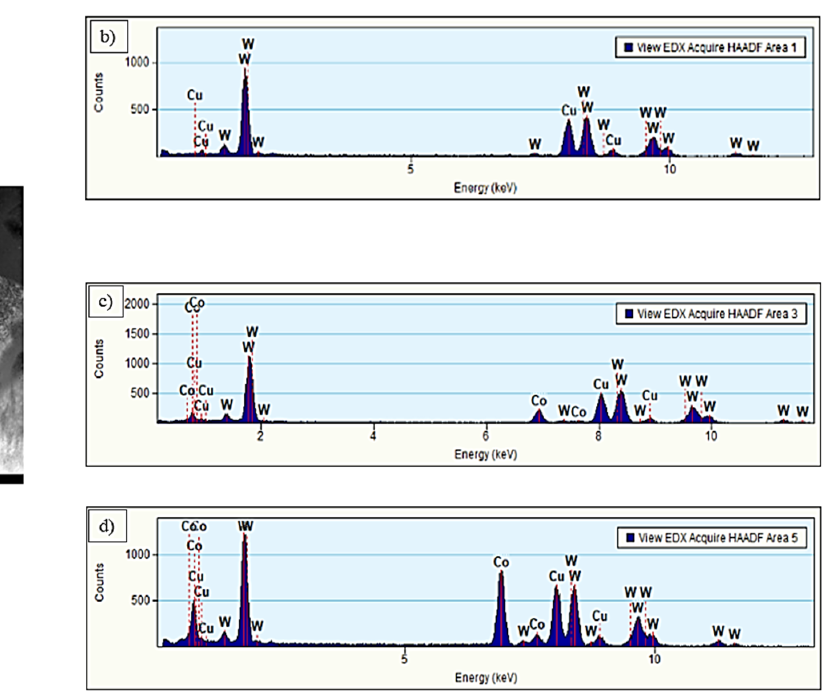
Figure 10. STEM micrograph in BF of sample C2 ( a ); ( b ) the results of chemical analysis for precipi- tation marked with letter A and ( c ) with letter B, ( d ) the results of chemical analysis for matrix marked with letter C.